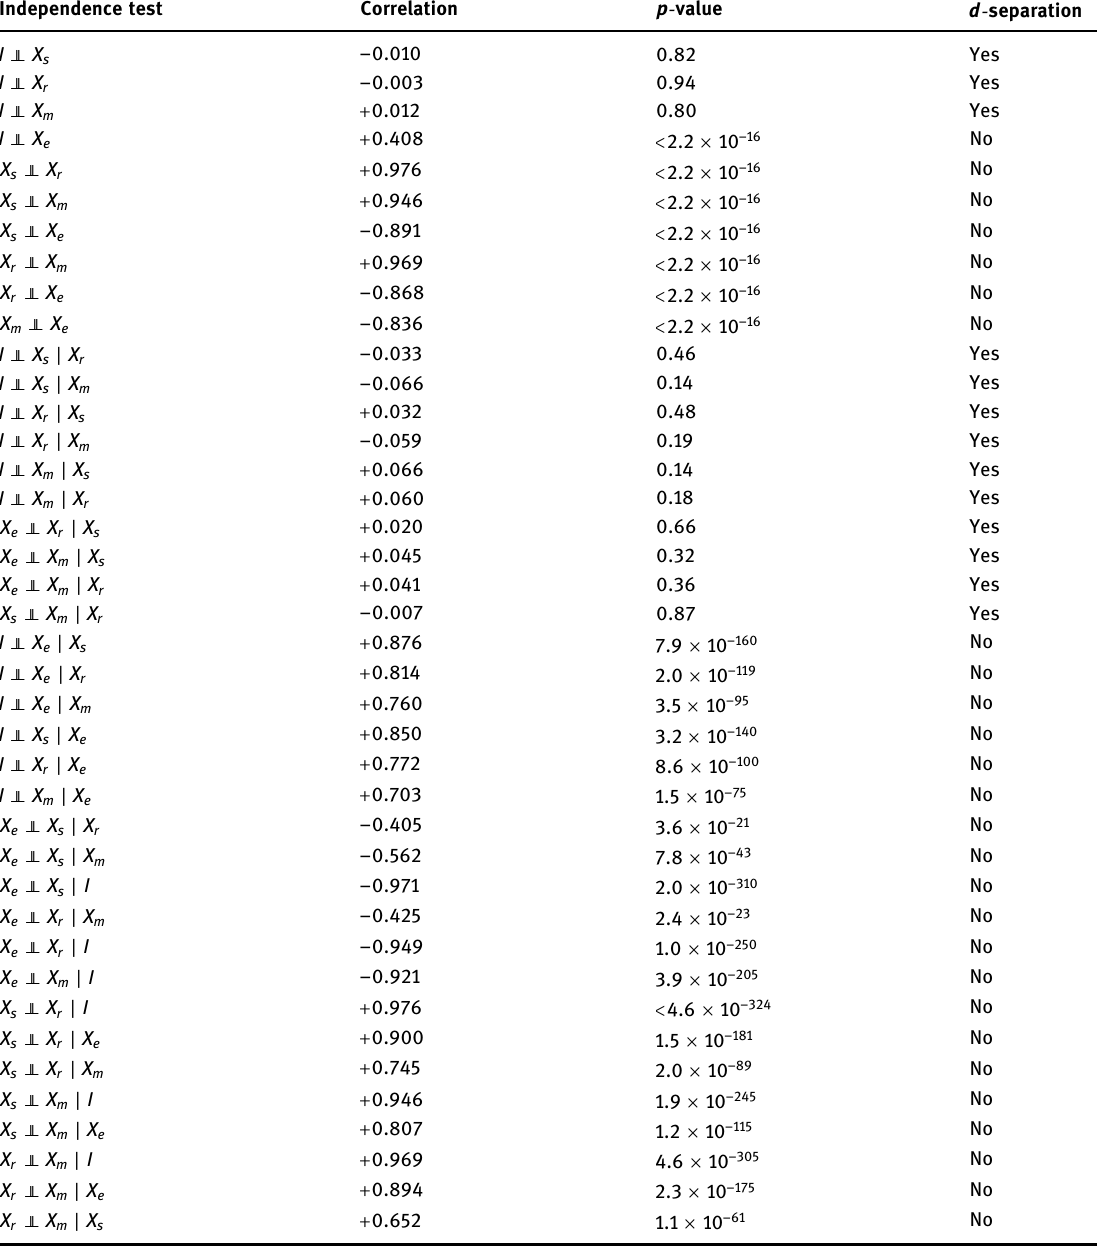
Table A1: The conditional independences in the simulation of the protein pathway ( described in Section 5.2 and Appendix C ) were assessed using Spearman ’ s rank correlations. With a p - value threshold of 0.01, d - separations with a separating set of size 0 or 1 coincide with conditional independence test